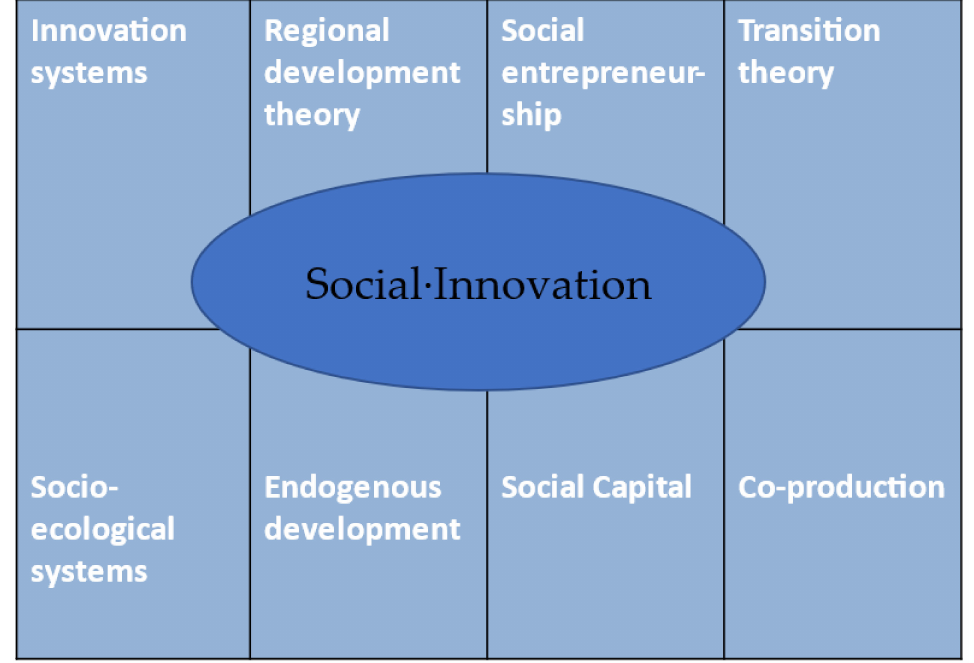
Figure 2. Theories offering insights into social innovation. Source: authors’ own